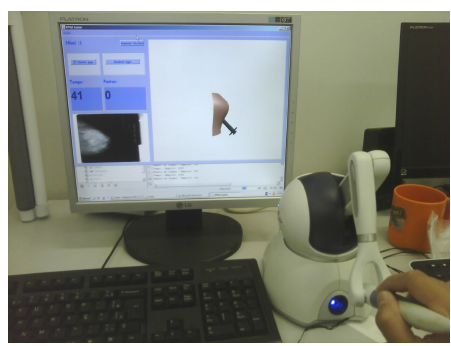
Figure 12. Execution of the game with the haptic